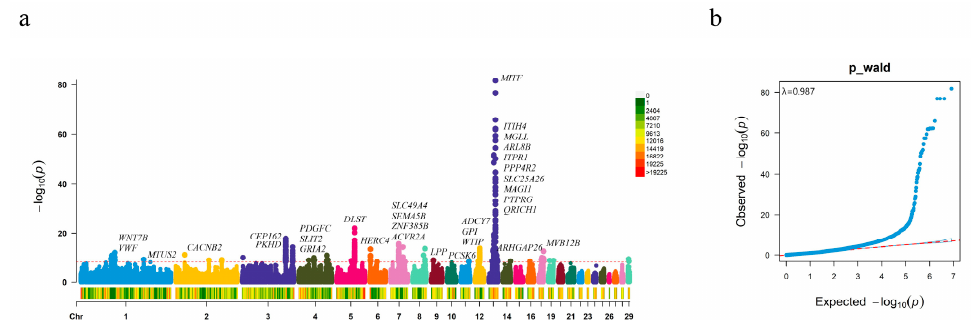
Figure 3. Genome-wide association study results for white plumage. ( a ) Manhattan plot of GWAS results. The Y -axis shows − log10 ( p -values). The two red dashed horizontal line indicates genome- wide significance thresholds (6.042978 × 10 − 9 ). ( b ) Q-Q plot. Lambda ( λ ) is the genomic expansion factor. A total of 24 ducks showed white plumage while 56 controls were spotty.